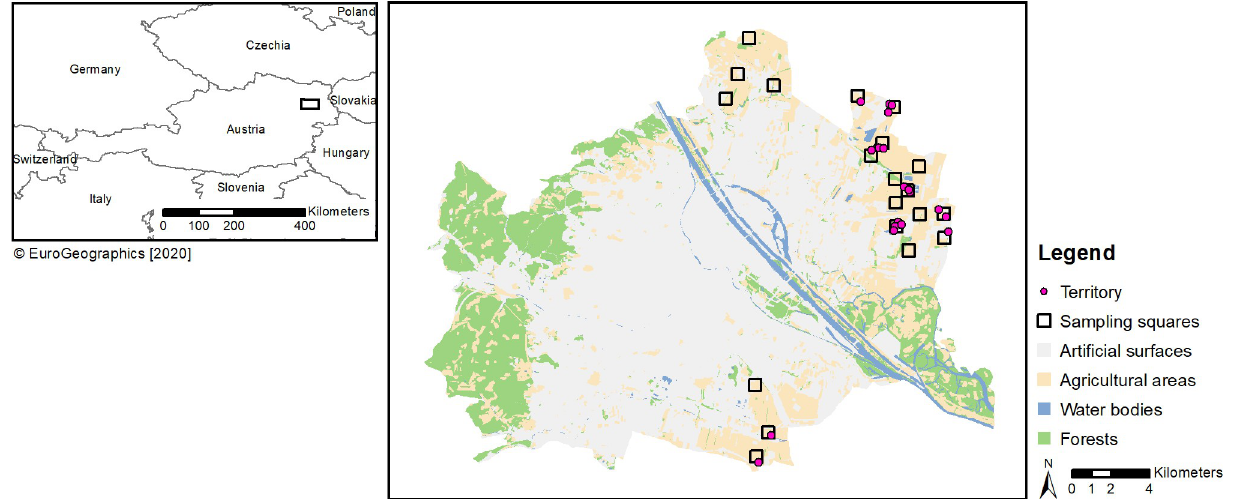
Fig 2. Spatial distribution of territorial pairs in spring 2017. Artificial surfaces include settlements and infrastructure (e.g., roads). Source Realnutzungskartierung 2016: Stadt Wien - https://data.wien.gv.at.